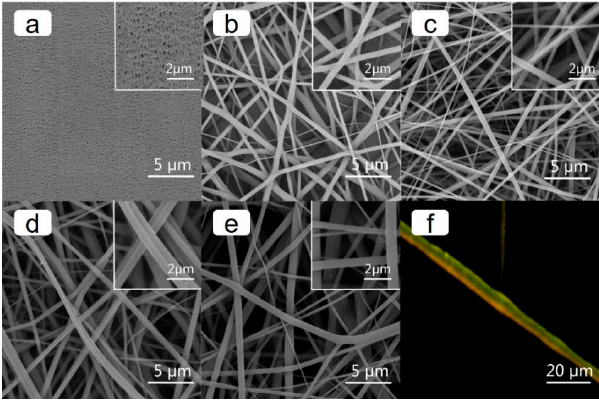
Figure 2. SEM images of ( a ) PE, ( b ) TPU, ( c ) PI, ( d ) TPU/PI and ( e ) TPU+PI membrane. ( f ) Fluorescence microscope images of TPU/PI.